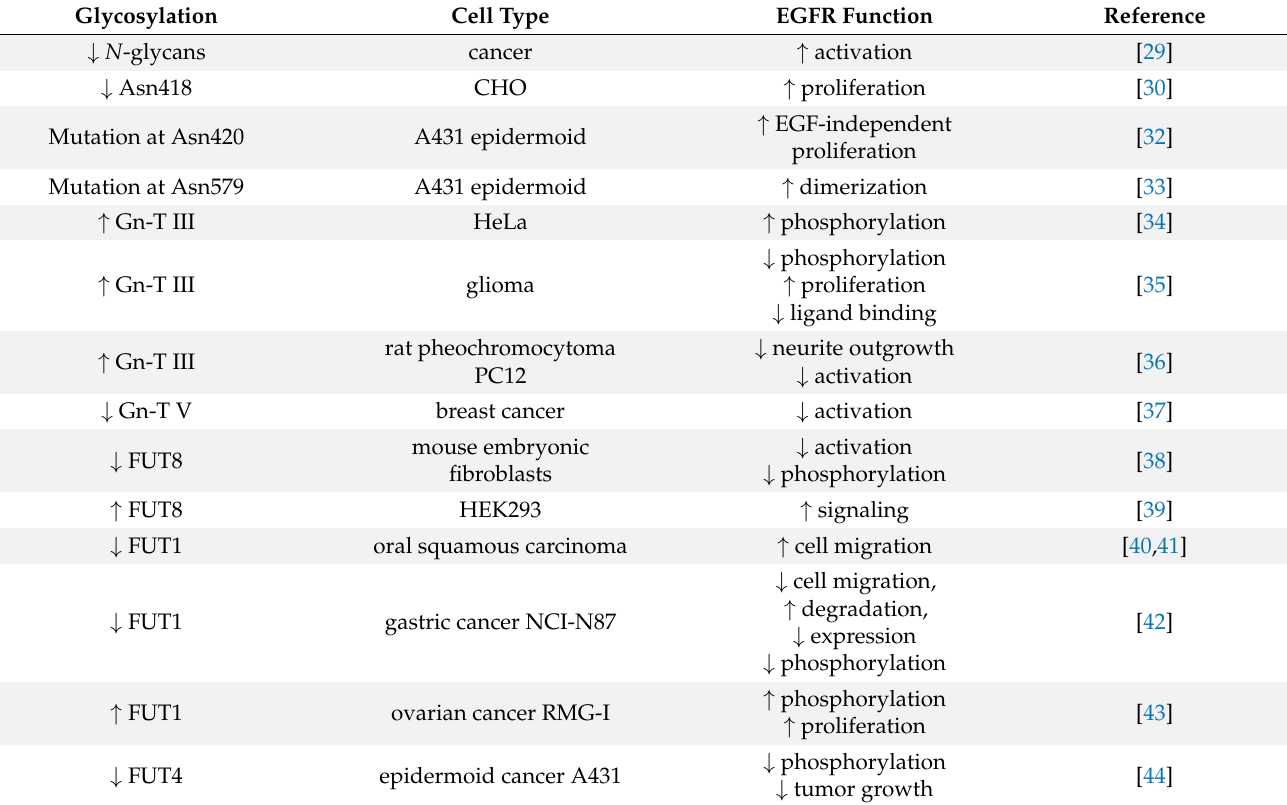
Table 2. Role of glycosylation in EGFR